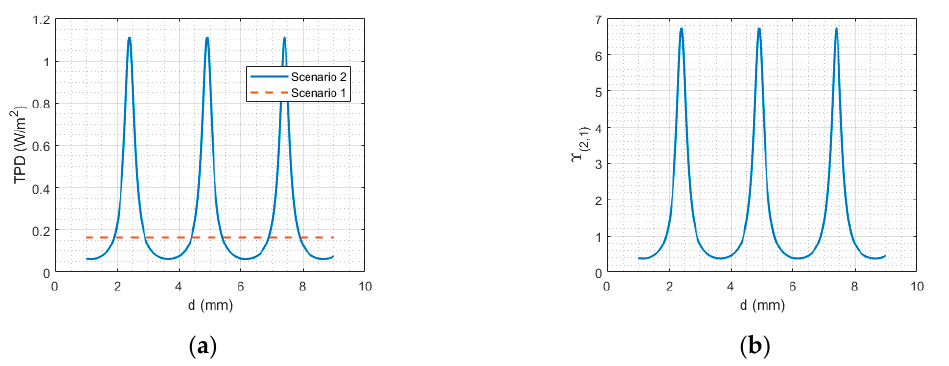
Figure 4. Plane-wave illumination without (scenario 1) and with (scenario 2) PEC: ( a ) transmitted power density (TPD); ( b ) TPD variations due to presence of PEC.